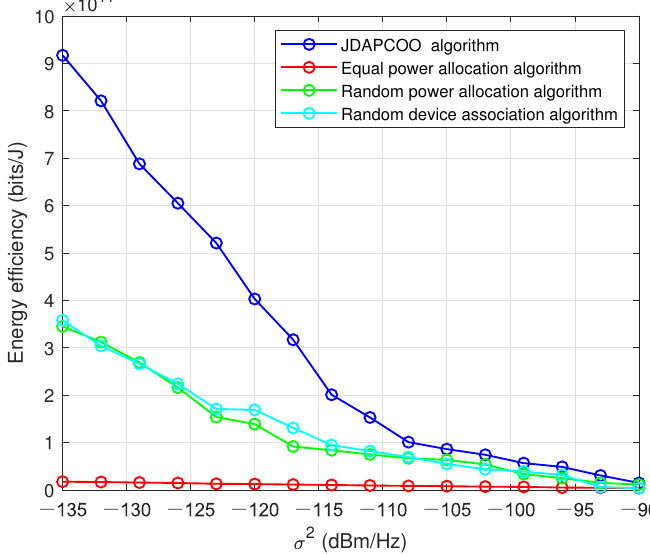
Figure 10. The relationship between the total system energy efficiency and the noise